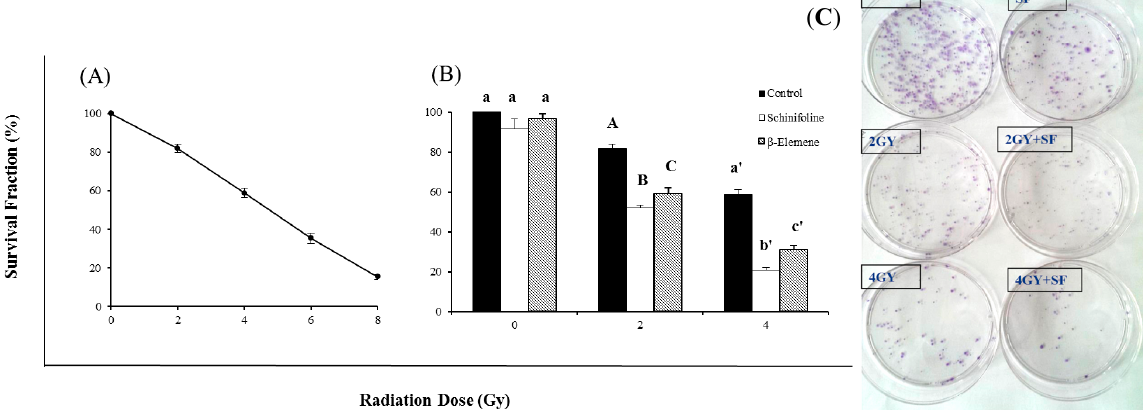
Figure 3. Colony forming assay of A549 cells after exposure to irradiation (IR) or IR in combination with β -elemene/schinifoline. ( A ) The curve represented the cells which were irradiated with different doses of 2, 4, 6 and 8 Gy, respectively. ( B ) Influence of β -elemene (15 µg/mL) and schinifoline (4 µg/mL) on the radiosensitivity of A549 cells. Colony forming efficiency was determined 14 days later and colonies containing at least 50 cells were scored. All data are obtained from three independent experiments, each performed in triplicate. Means under the same exposure dose (0, 2, or 4 Gy) followed by the same letters (a) do not differ significantly or followed by the different letters (A, B, C/a', b', c') differ significantly ( p < 0.01) in ANOVA and Tukey’s tests. ( C ) The representative picture of